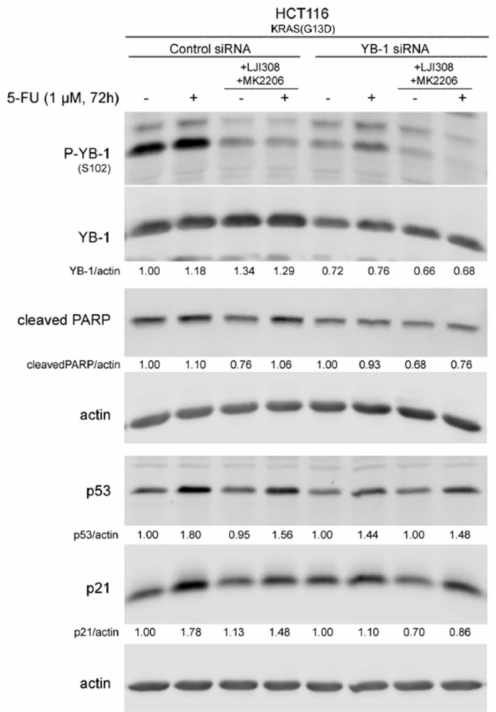
Figure 7. The 5-FU-induced expression of p53 and p21 as well as the inhibitory e ff ect of RSK and Akt inhibitors in KRAS(G13D)-mutated HCT116 cells are YB-1 dependent. KRAS(G13D)-mutated HCT116 cells were transfected with either 50 nM control siRNA or YB-1 siRNA. Twenty-four hours after transfection, cells were treated with and without 5-FU, LJI308 and MK2206 for 72 h, and protein samples were isolated. Phosphorylation and expression of the indicated proteins were analyzed by Western blotting. All densitometry values were obtained from the ratio of the indicated proteins to actin. The values for YB-1 were normalized to nontreated siRNA-transfected conditions. The ratio of YB-1 to actin was normalized to the nontreated control siRNA-transfected